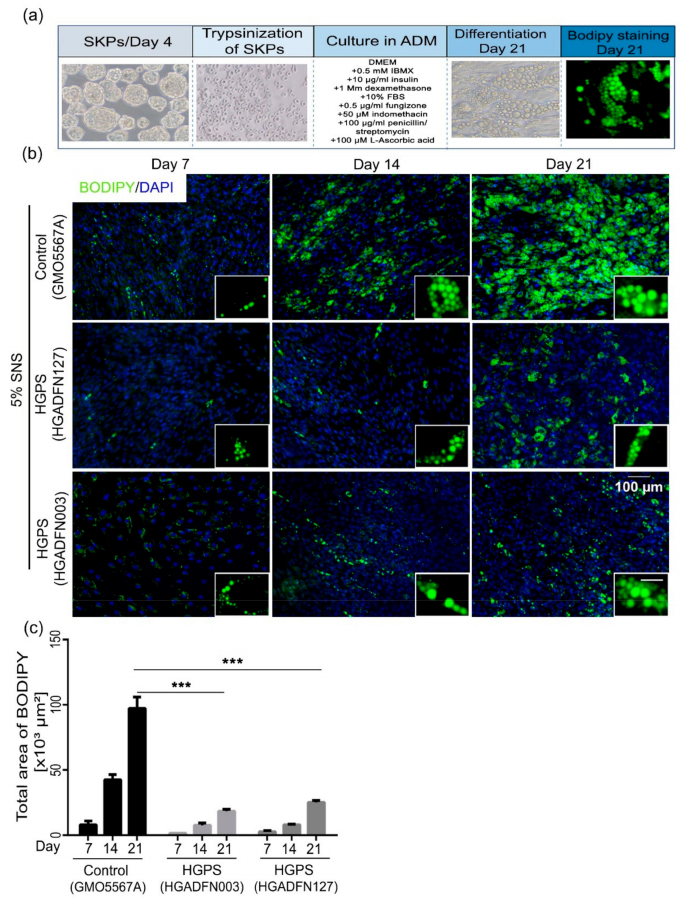
Figure 5. Differentiation of trypsinized SKPs into adipocytes. ( a ) Panel showing the optimized protocol for SKP trypsinization at day 4 and differentiation into adipocytes. The spheroids were trypsinized at day 4 and cultured directly in ADM. The differentiated cells were observed for 21 days and then stained with ORO and Bodipy at day 21. ( b ) Bodipy staining of lipid vesicles for control (GMO5567A) and HGPS (HGADFN127 and HGADFN003) cells, starting from 5% SNS fibroblast cultures. Staining was performed at days 7, 14, and 21 of differentiation. Cells were counterstained with DAPI. Scale bar: 100 µ m; for the magnified images, scale bar: 20 µ m. ( c ) Quantification of area with Bodipy signals at the three time points for both control and HGPS adipocytes. Values are presented as mean ± SD ( n = 3), *** p < 0.001, ( c ) two-way ANOVA with Tukey’s multiple comparisons